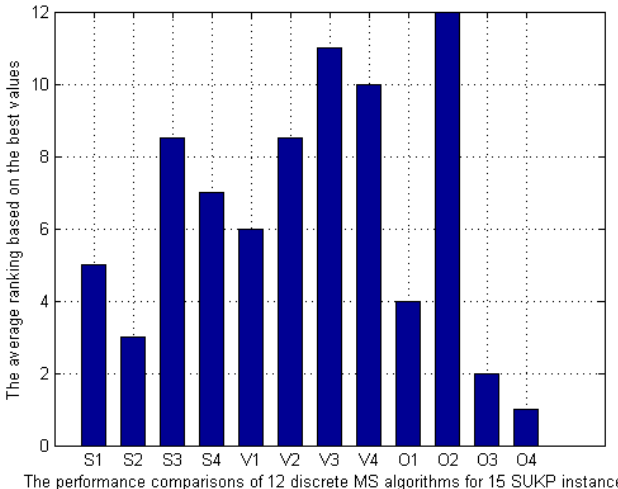
Figure 3. Comparison of the average rank of 12 discrete MS algorithms for 15 SUKP instances.